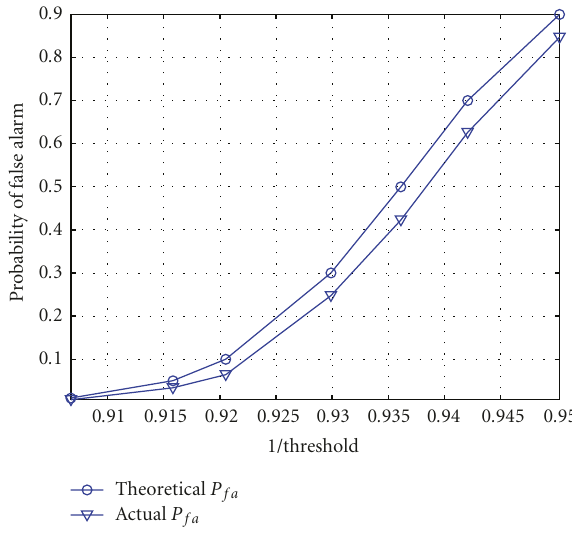
Figure 3: Comparison of theoretical and actual P fa